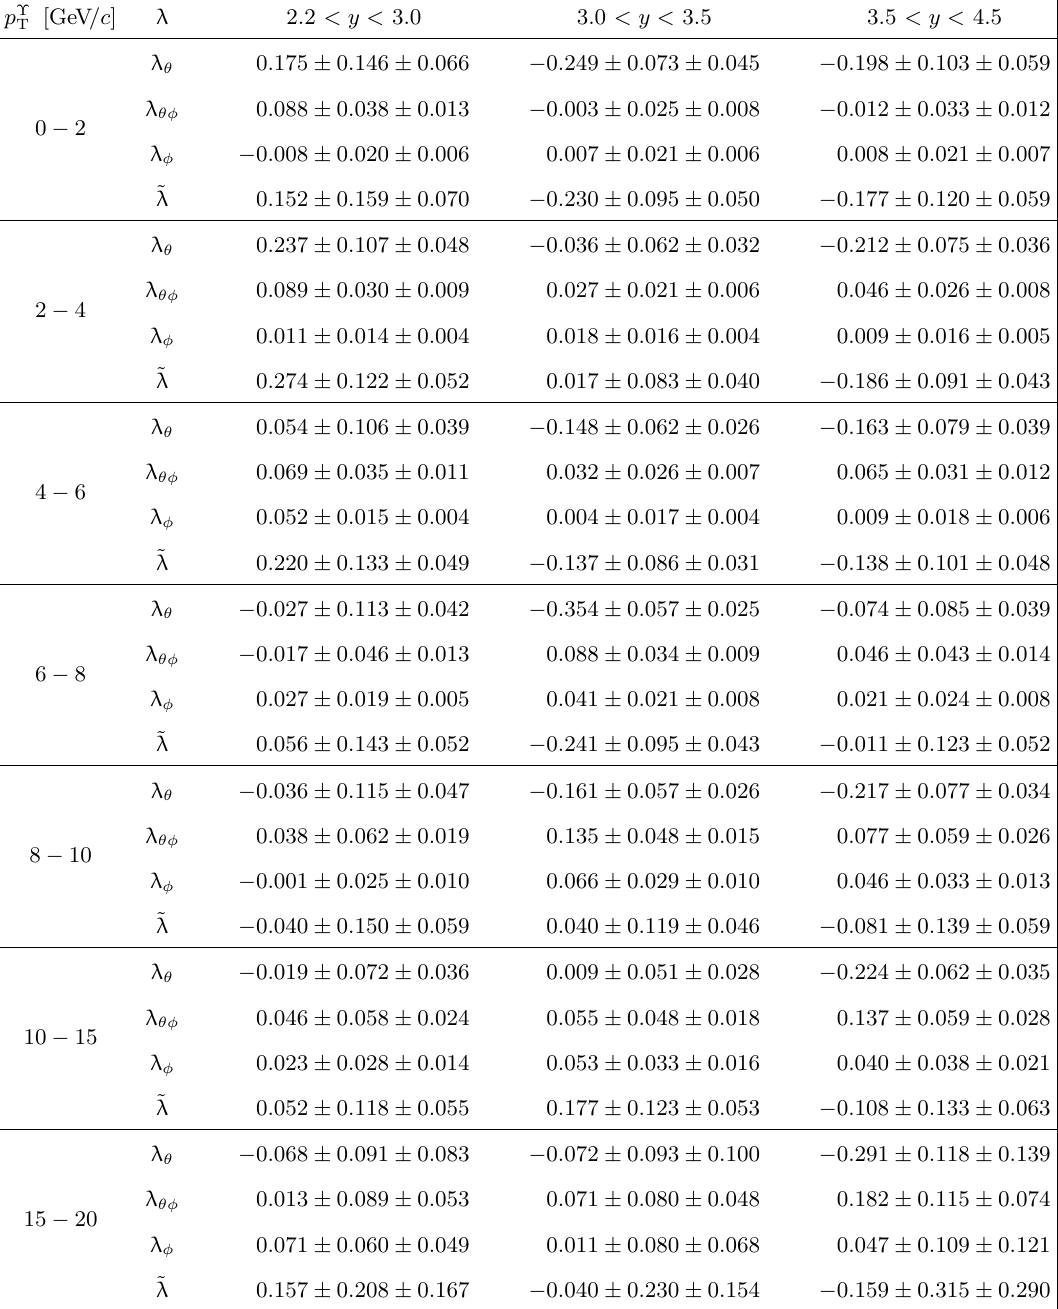
Table 13 . Values of (cid:21) (cid:18) , (cid:21) (cid:18)(cid:30) , (cid:21) (cid:30) and ~ (cid:21) measured in the CS frame for the (cid:7)(2S) produced at p s = 7 TeV. The (cid:12)rst uncertainty is statistical and the second